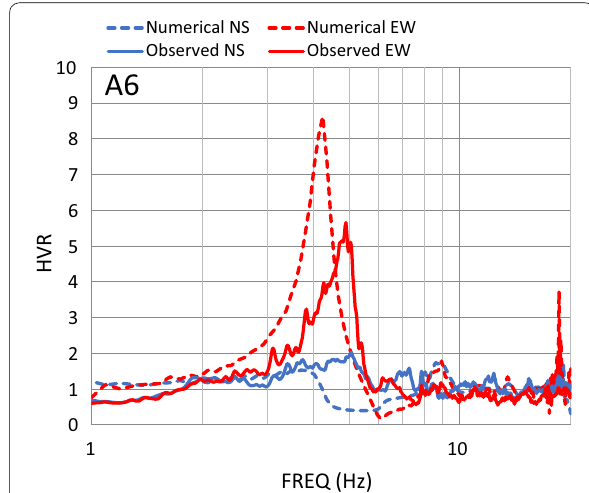
Fig. 15 Comparison of the observed MHVRs ( solid blue and red lines ) with the numerical MHVRs ( broken blue and red lines ) for point A6. The numerical MHVRs show the same directional dependence as the observed